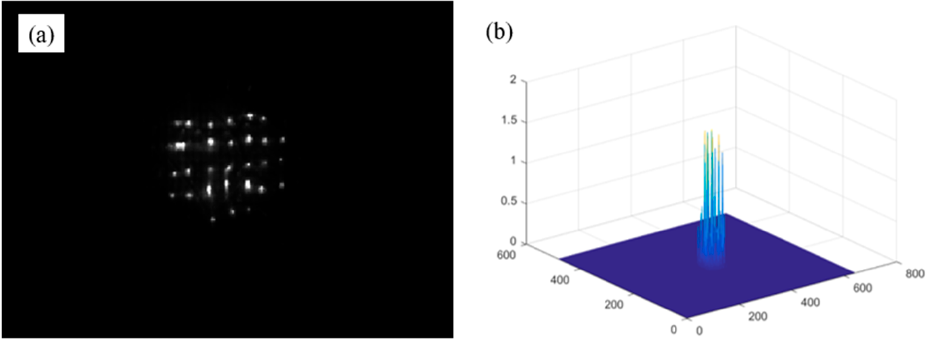
Figure 3. The intensity image. ( a ) The image of average light intensity; ( b ) 3D image of light inten ‐ sity.